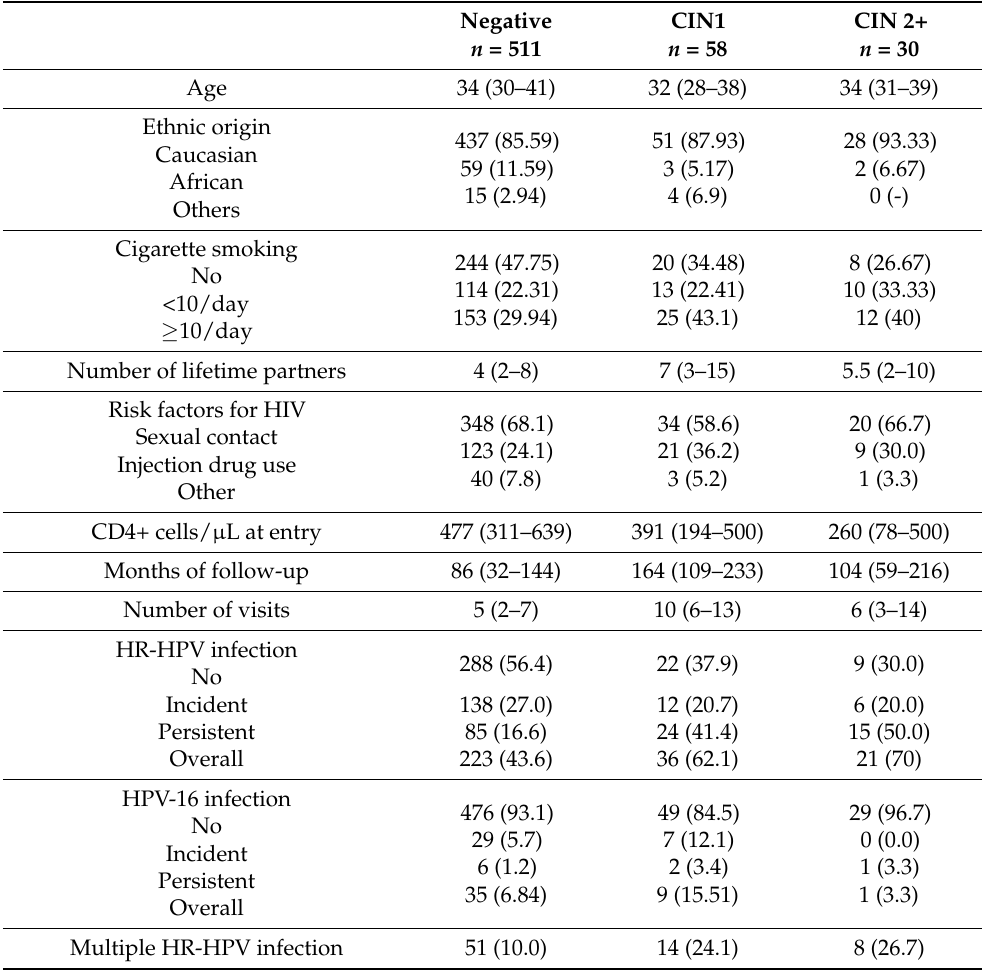
Table 2. Univariate association between anamnestic and clinical variables and subsequent cervical histological diagnoses during